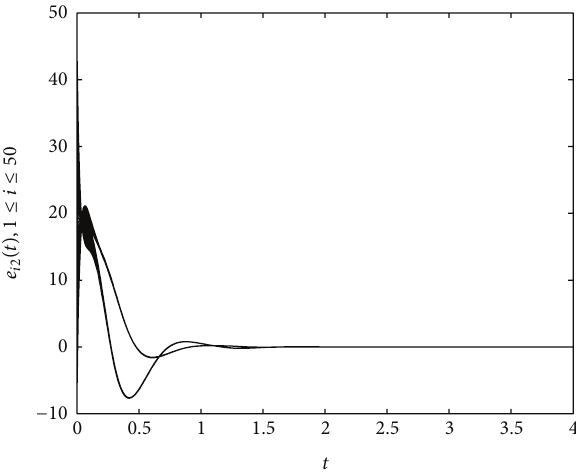
Figure 9: Synchronization errors 𝑒 𝑖 2 , 1 ≤ 𝑖 ≤ 50, with control parameters 𝑘 = 5, 𝑇 = 0 . 5, and 𝜃 = 0 . 1.